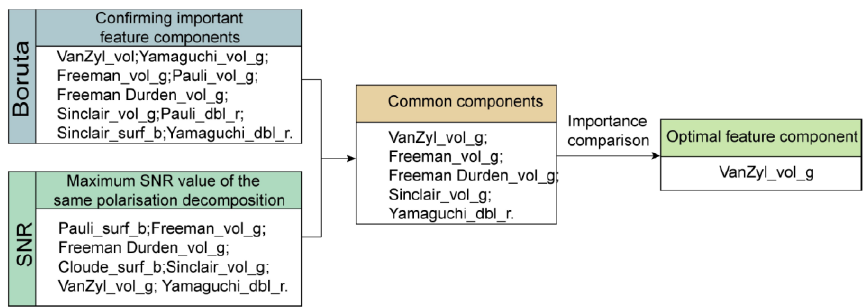
Figure 7. The optimal feature component selection process.